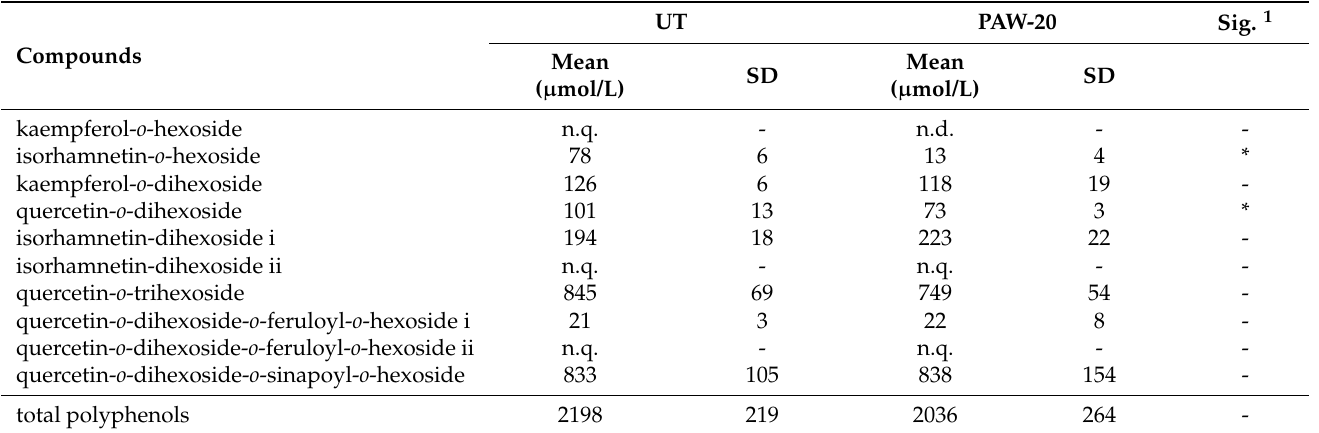
Table 3. Polyphenol concentrations ( µ mol/L) determined in methanolic extracts of rocket salad washed in PAW for 20 min (PAW-20) or in the untreated sample (UT). Values are reported as means of three replicates ± standard deviation